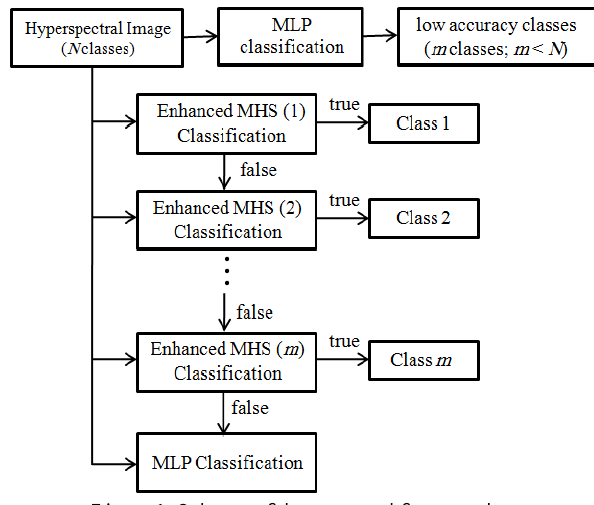
Figure 1. Schema of the proposed